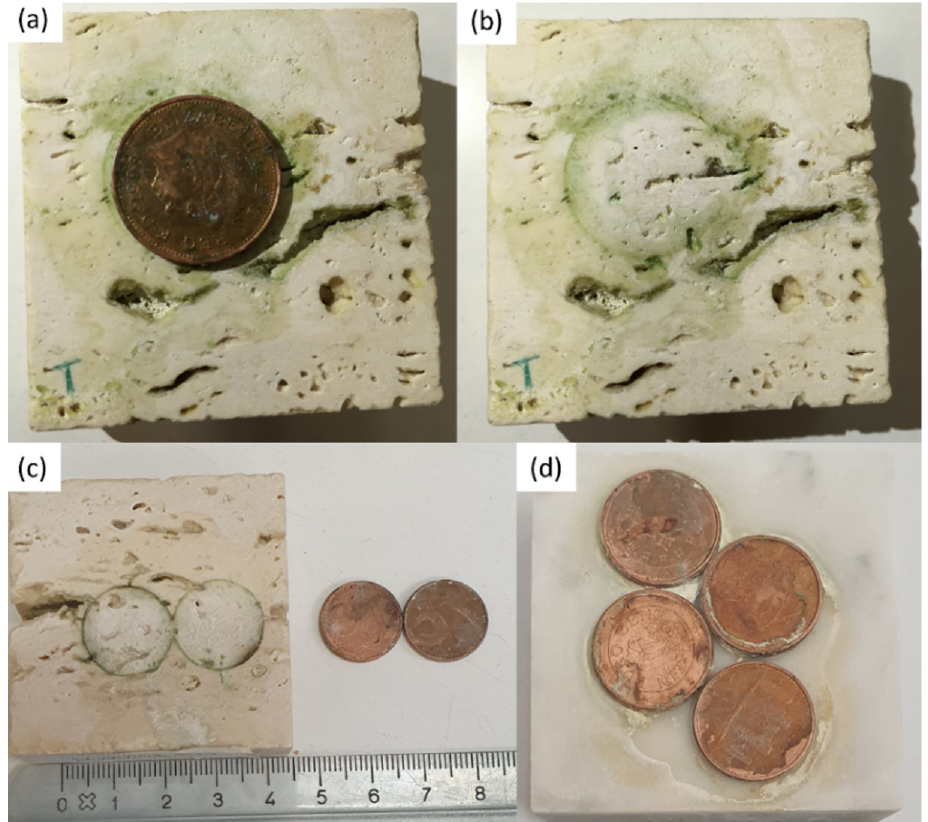
Figure 9. In ( a , b ) Travertine sample stained by corrosion products of one penny reacting with citric acid; the greenish-black stain on Travertine produced by reaction of two euro cents with citric acid in ( c ); in ( d ) Carrara marble surface with acidic corrosion of four euro cents with citric acid. The coins and the reagent (i.e., citric acid) were left on the stones surface for one week. After that, the coins were removed from the stones surface and a greenish-black stain was observed (see Figure 9). Each stone surface was treated by the PVA-PEO-borax gel, which was applied in a thin layer and left on the stone surface for 30 min. After this time, the gel layer was peeled off (see Figure 10) and it was left drying and then preserved for Raman analysis. The cleaned stones surfaces (Figure 11) showed a different appearance. The two Travertine samples showed at the naked eye the presence of transparent gel residues in the pores (zoomed portions of Figure 11a,b). All the surfaces were left drying before performing NMR